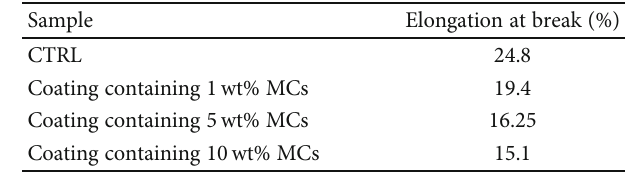
Table 3: Adhesion strength results of the prepared coatings. Sample